Question: Briefly state, in one sentence, what is plotted here.
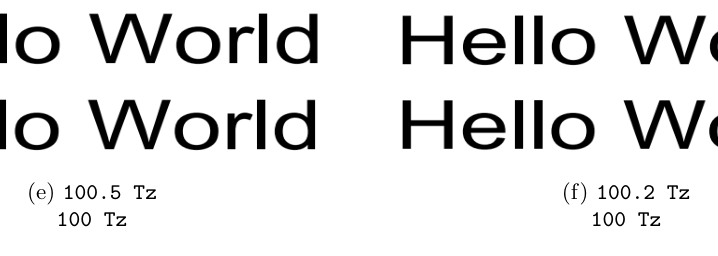
Answer: Tz Operator - control, 10%, 5%, 1%, 0.5%, 0.2% (0.5%)